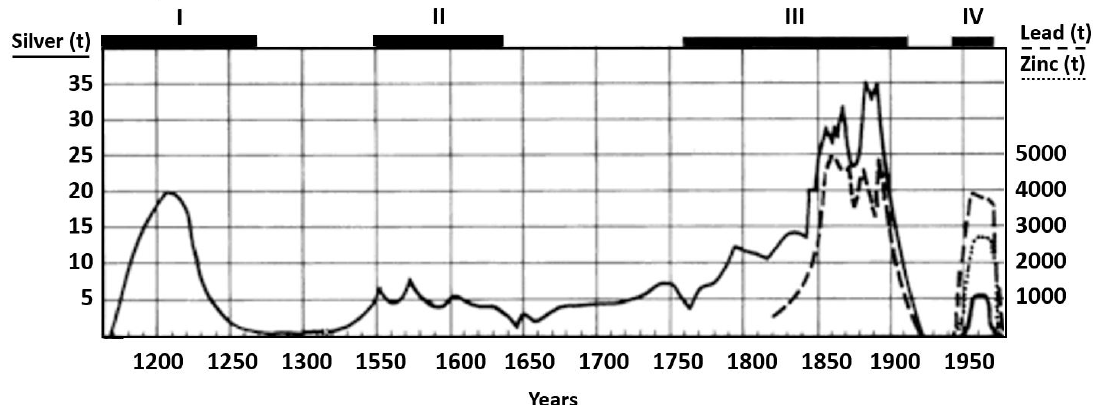
Figure 2. The history of production in Freiberg (modified after Bayer [53]).